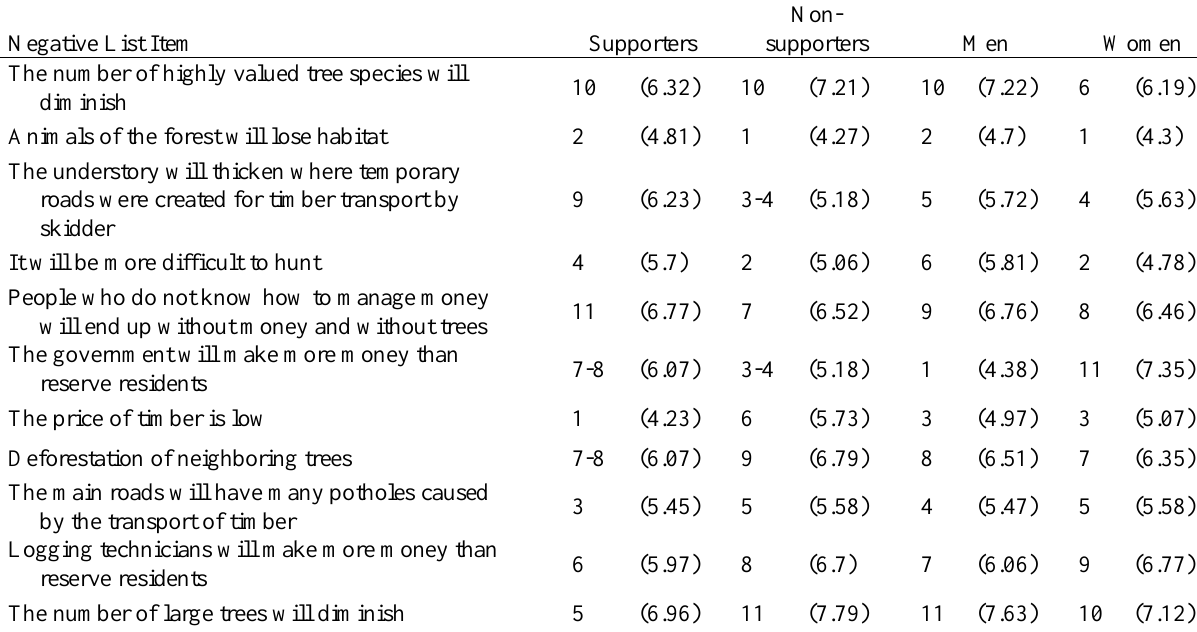
Table A3.2. Results from rank order activity using fixed lists of negative aspects of logging in sustainable use protected areas (1=most